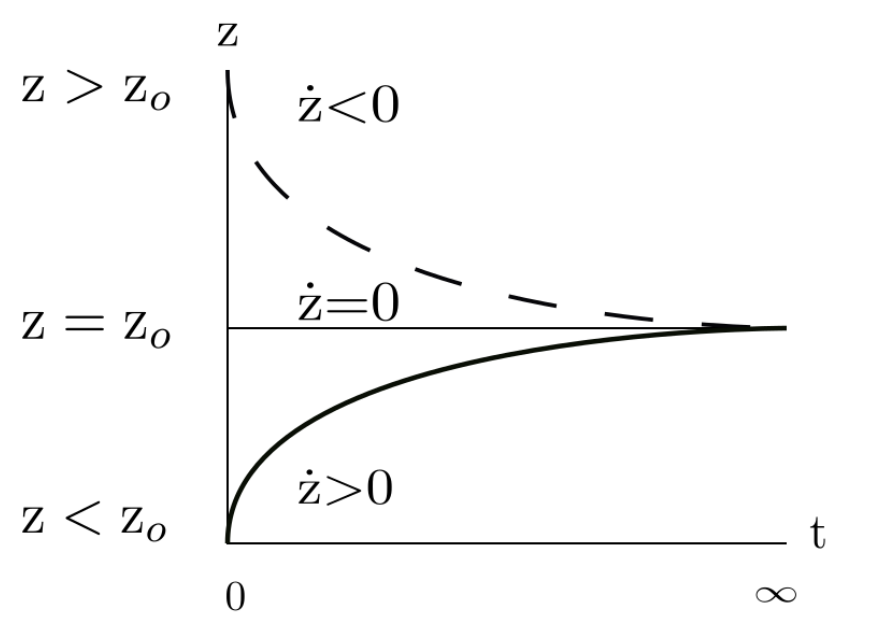
Figure 1. Behavior of intracellular quota z over time under three conditions of the state variable. According to the definition of zc 0 , z must be greater than zc 0 to have biological meaning. Note that when z > zc 0 , ˙ z is negative. This means that during that time, z decrease, and for z < zc 0 , ˙ z is positive, which implies that the minimum concentration of the limiting nutrient per cell required before growth can proceed, is trying to be reached. Therefore, during that time, there is no biomass production until z = zc 0 is reached. However, when z = zc 0 , biomass production is evidently available. Note that lim y → ∞ = 0 at ¯ v 1 , which implies that lim z → ∞ = zc 0 for all t > 0 in batch mode